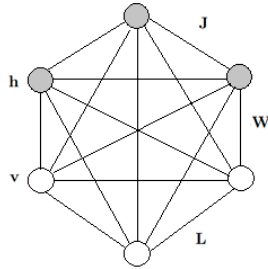
Figure 1. A general Boltzmann machine.